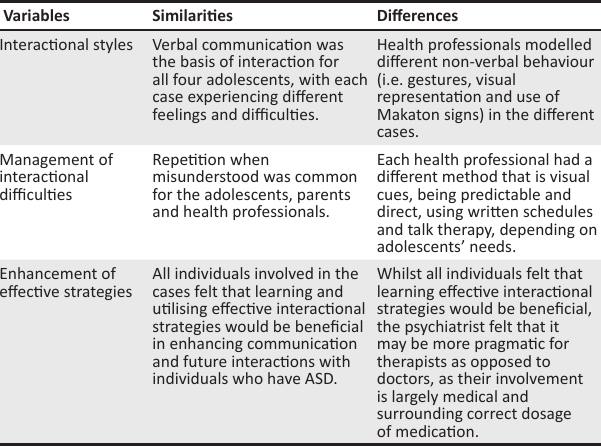
TABLE 2: A cross-analysis review of emerging themes in adolescents with autism spectrum disorder’s communication.